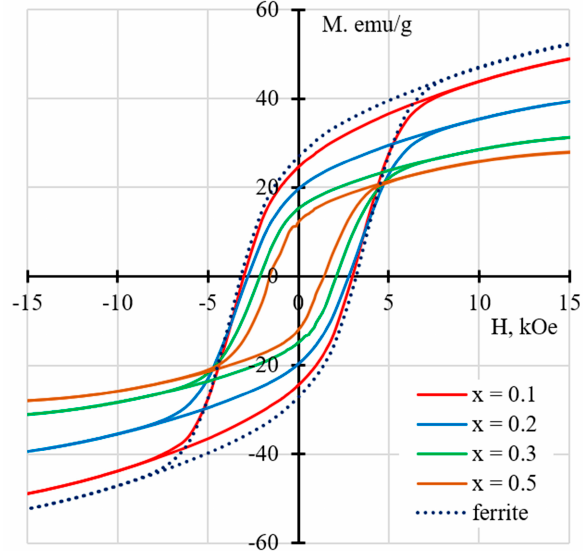
Figure 10. Magnetic hysteresis loops for ME ceramics 50 wt.% PZTNB-1 + 50 wt.% Pb 1 − x La x Fe 12 − x Zn x O 19 and pure ferrite with x = 0.2 (dashed curve).